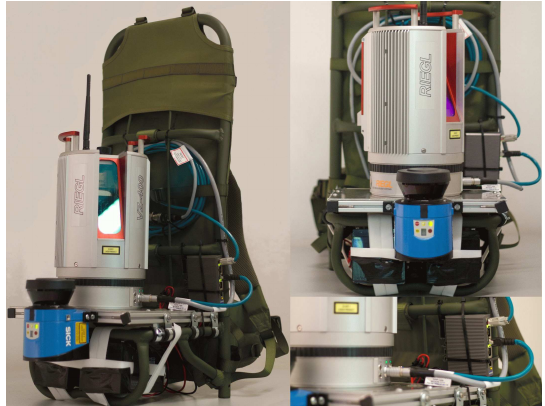
Figure 2. Images of the backpack system. Left: Side view with all of its sensors and equipment. Right: Detailed view of the SICK and the switch.